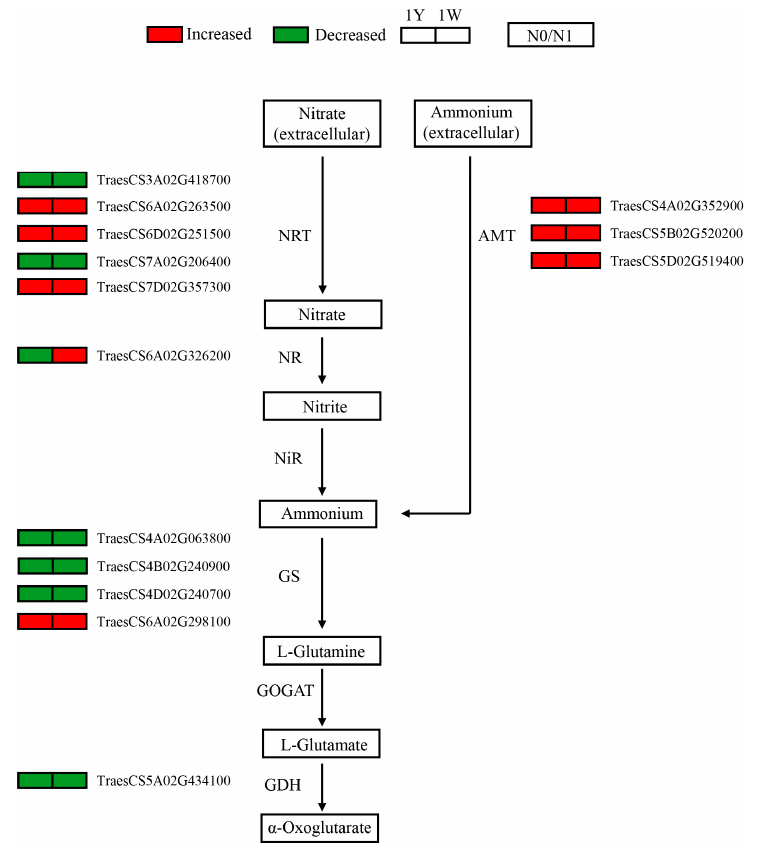
Figure 4. Nitrogen metabolism genes are responsive to N deficiency in each wheat NIL. The relative levels of these differential expression genes are indicated by red and green. Red boxes represent upregulated and green boxes denote downregulated. NRT, nitrate transporter; AMT, ammonium transporter; NR, nitrate reductase; Nir, ferredoxin-nitrite reductase; GS, glutamine synthetase; GOGAT, glutamate synthase; GDH, glutamate dehydrogenase.